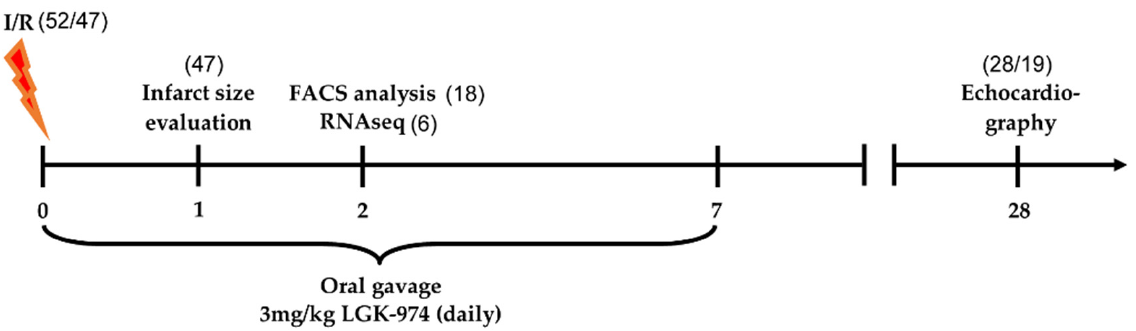
Figure 1. Timeline and animal use of in vivo experiments. Numbers in brackets represent the animals used in the experiments. In total, 52 mice underwent ischemia/reperfusion (I/R) surgery, of which five animals died during or shortly after the procedure. Blood was drawn from the surviving animals (47) for troponin T measurements. 18 (9 per group) animals were sacrificed for flow cytometric analysis, 6 (3 per group) were sacrificed for RNA seq experiments. In total, 19 animals (8 in the DMSO group and 11 in the LGK-974 group) were used for echocardiographic and histological evaluation; four animals had no elevated troponin T levels and were excluded from the analysis.